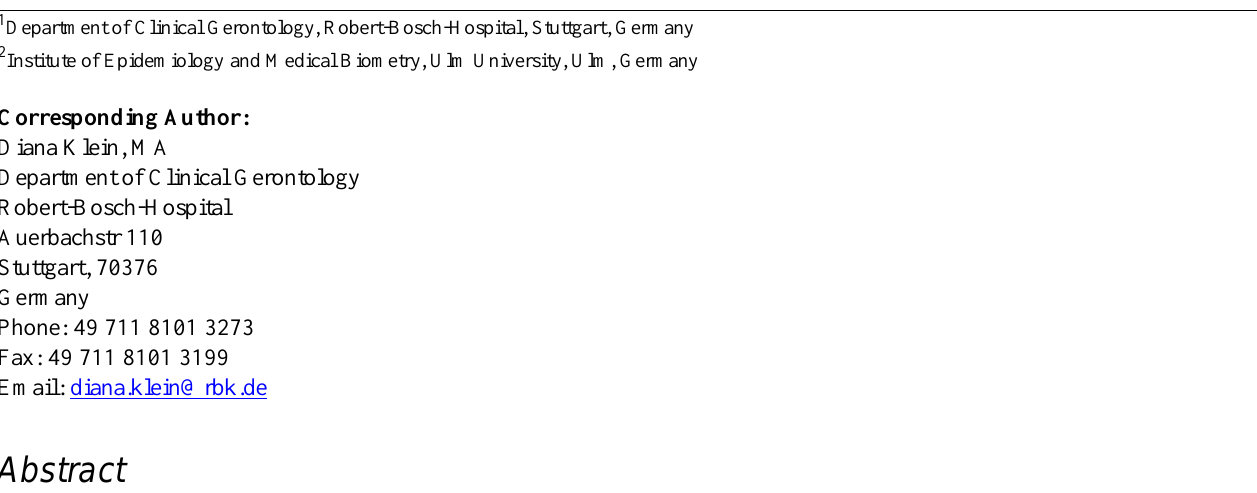
falls; accidental falls; population-based intervention; fall prevention; community; aged; risk